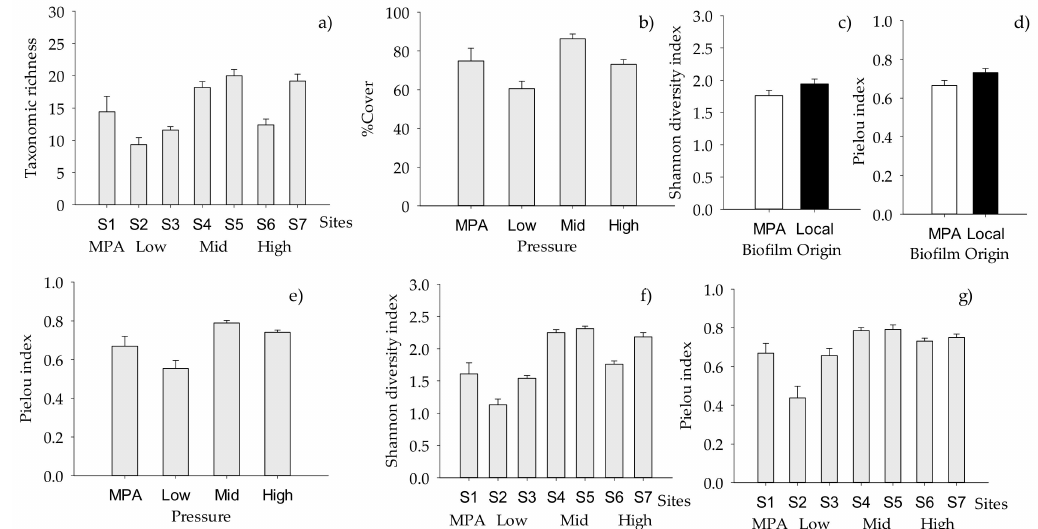
Figure 3. Mean ( + SE, per panel) total number of macrofouling taxa across “Sites”; ( a ) ( n = 10); ( b ) total percentage cover across “Pressure” levels ( n = 20, n = 10 for MPA); values of ( c ) Shannon and ( d ) Pielou indices showing di ff erences between “Origin of biofilm” ( n = 30 for local, n = 40 for MPA) and among “Pressure levels” for ( e ) Pielou index values ( n = 20, n = 10 for MPA); values of ( f ) Shannon and ( g ) Pielou indices showing di ff erences between “Sites” ( n = 10) (for further details, see Table 5, where significance of factors and interactions are indicated).